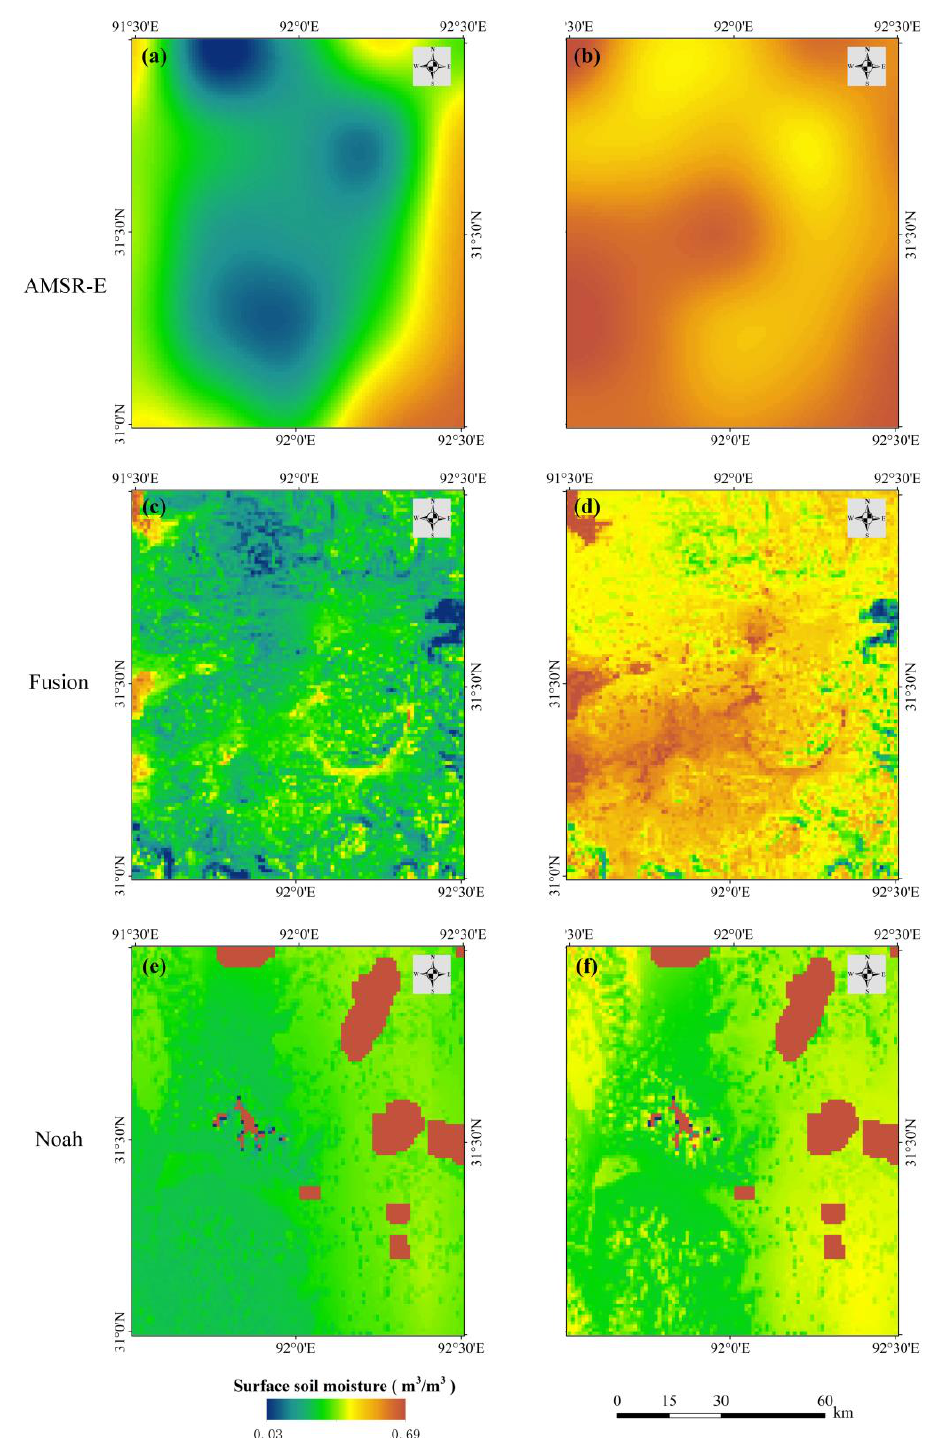
Figure 5. The spatial distribution of AMSR-E SSM (upper), fused MODIS SSM (middle) and Noah SSM at different dates in 1 km pixel size; ( a , c , e ) are data at 31 August 2010; ( b , d , f ) are data at 13 September